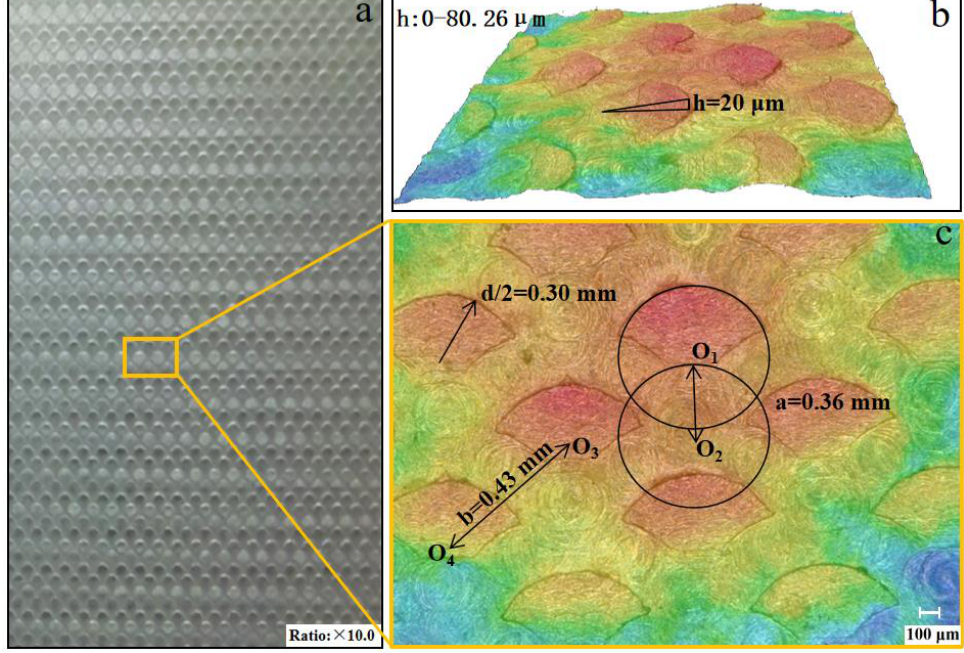
Figure 2. The aluminum artificial sample. ( a ) A sample with scale-like morphology; ( b ) The height “ h ” of the artificial sample under 200 times magnification; ( c ) The structural details of “ a ” , ” b ” and “ d ” .